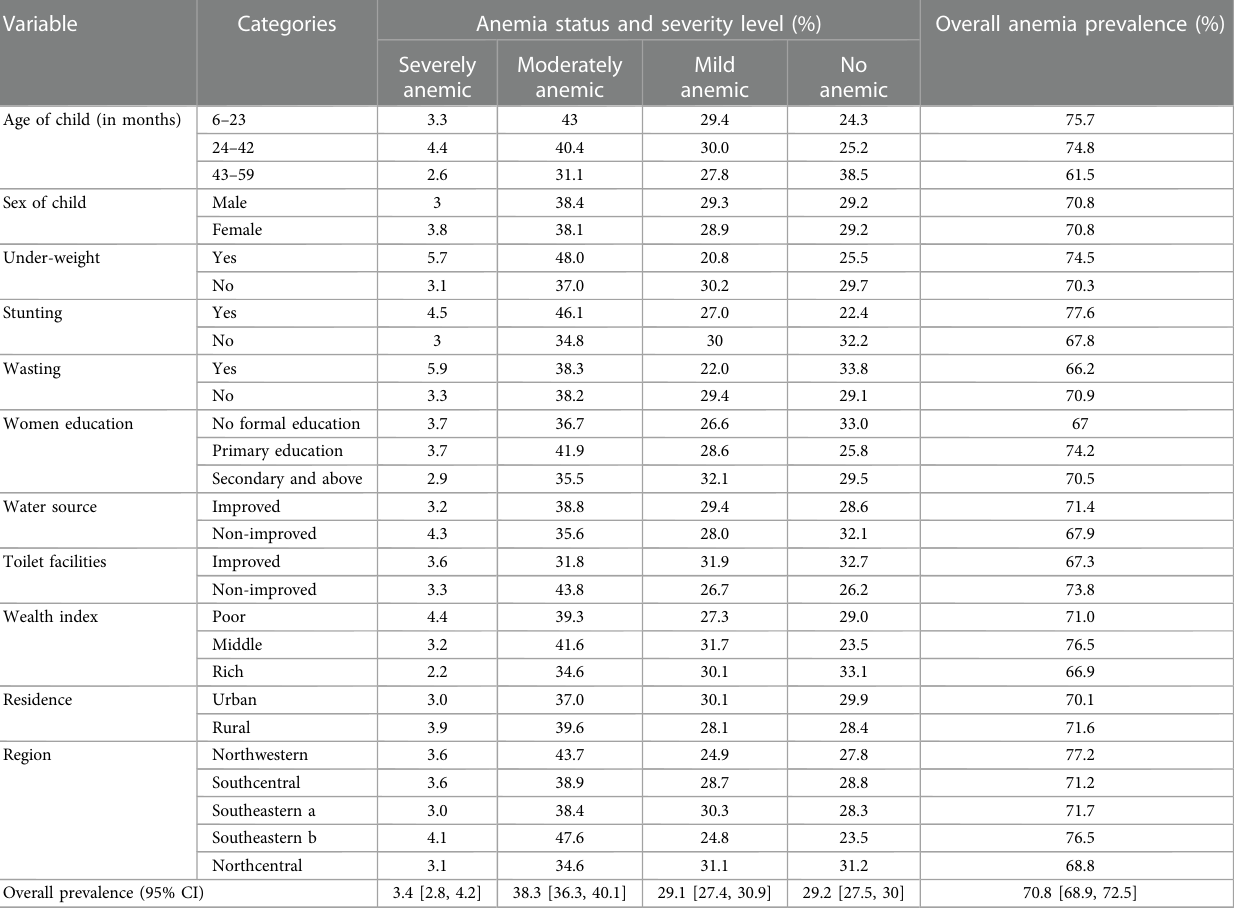
TABLE 2 The prevalence and severity of anemia based on the child-related, household, paternal, and community-level characteristics in Liberia ( N = 2,524). Variable